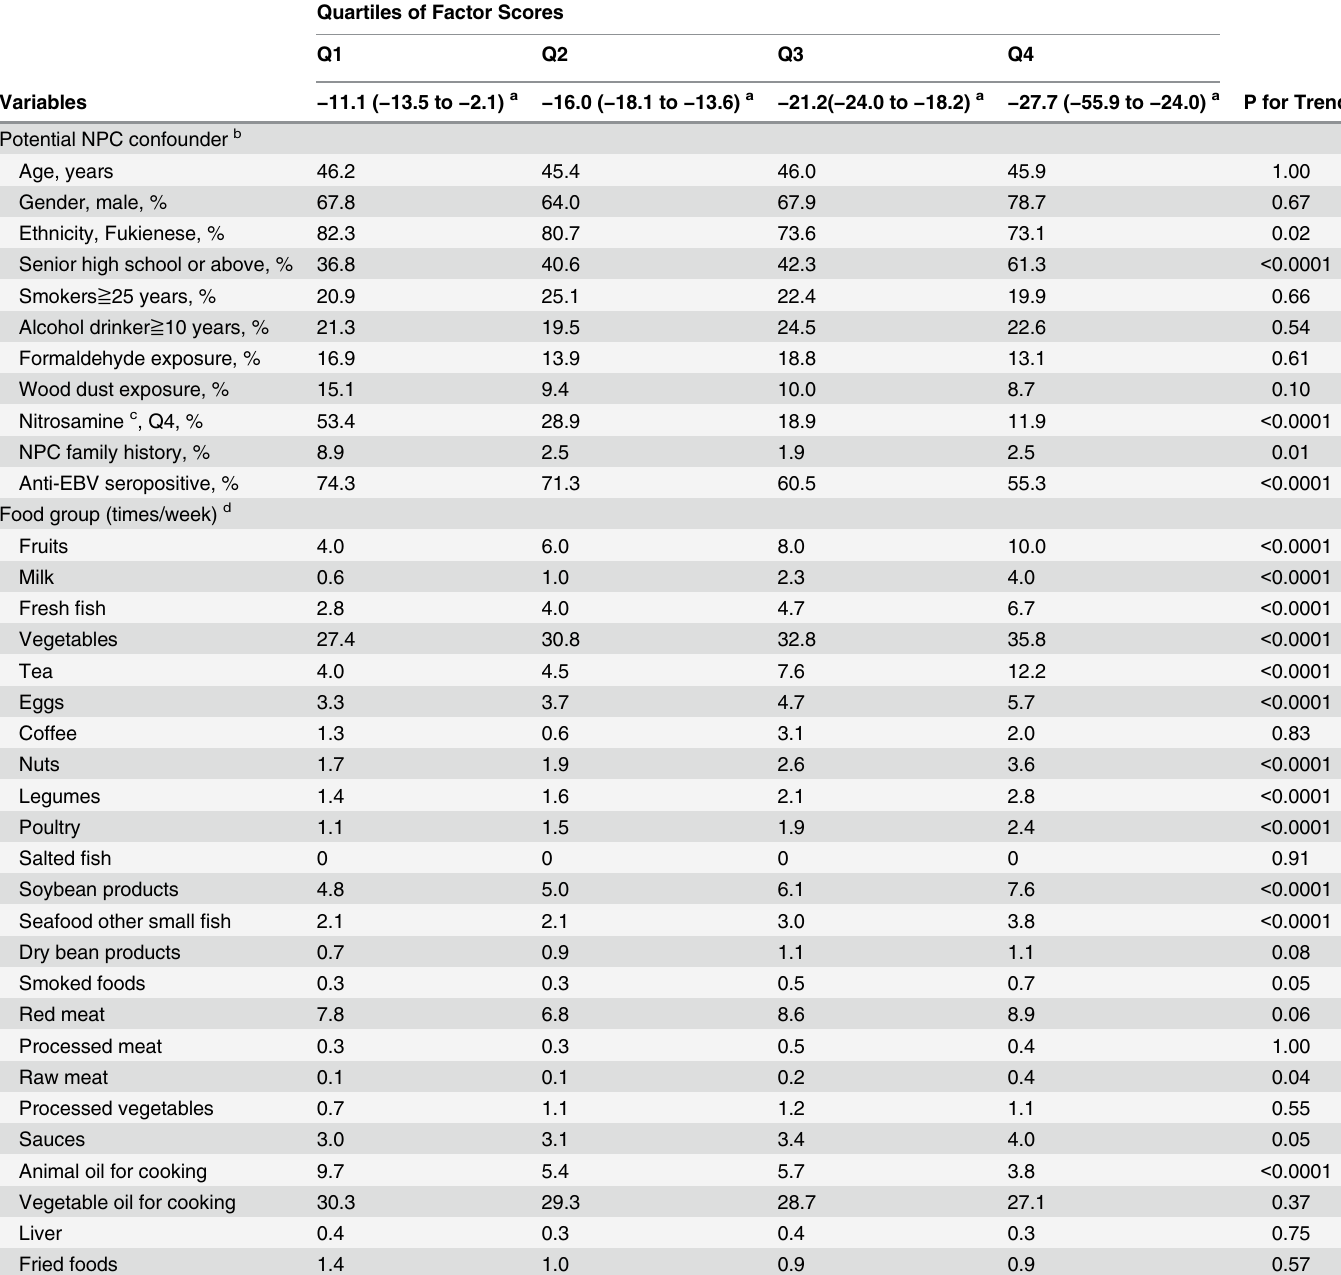
Table 3. Distribution of Potential Confounders and Mean Food Frequency by Quartiles of Dietary Factor Scores. Quartiles of Factor Scores Q1 Q2 Q3